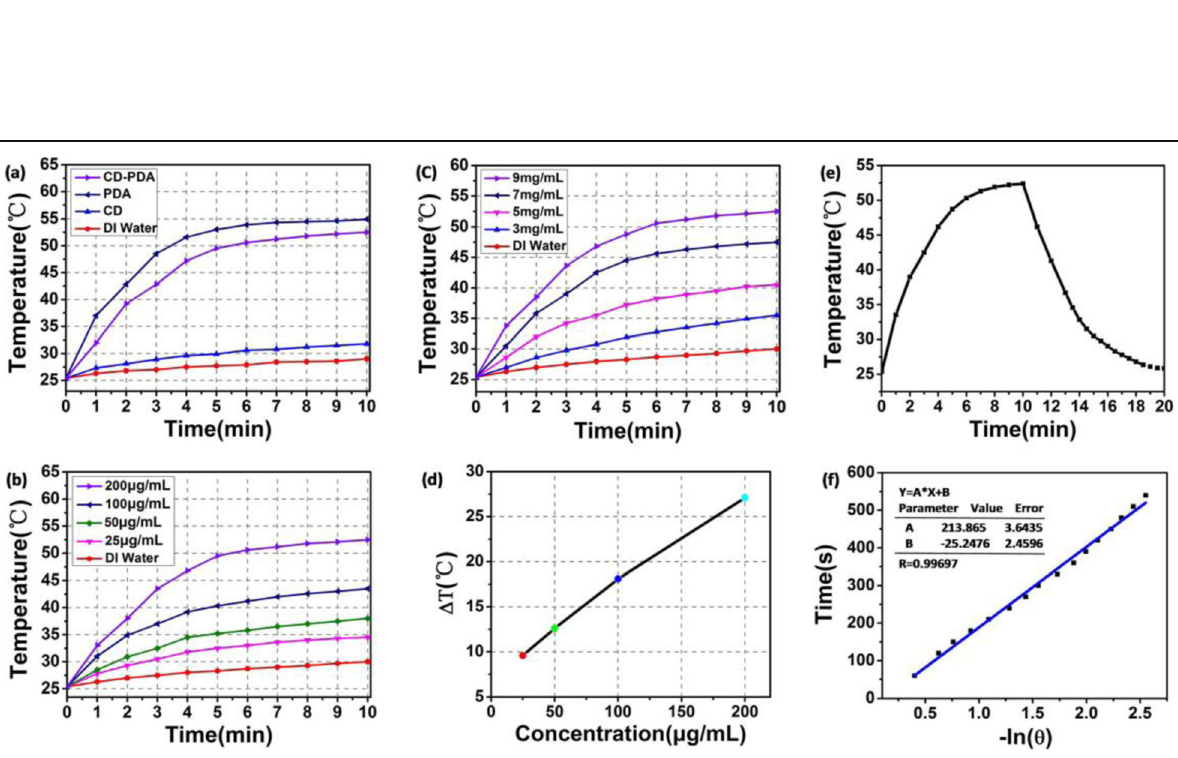
Fig. 4 Photothermal conversion properties of CD-PDA and CDs. a Photothermal heating curves of CD-PDA, CDs, PDA, and DI water under a power density of 2 W/cm 2 NIR laser irradiation for 10 min. b Photothermal heating curves of CD-PDA at various concentrations during 10 min. c Photothermal heating curves of CD-PDA (200 μ g/mL) with various original DA concentrations in Tris buffer. d Temperature increment of CD-PDA at various concentrations. e Cooling curve of CD-PDA (under a power density of 2 W/cm 2 NIR irradiation in the first 10 min and naturally cooling to the room temperature). f Leaner time data versus − ln θ calculated according to the cooling curve of